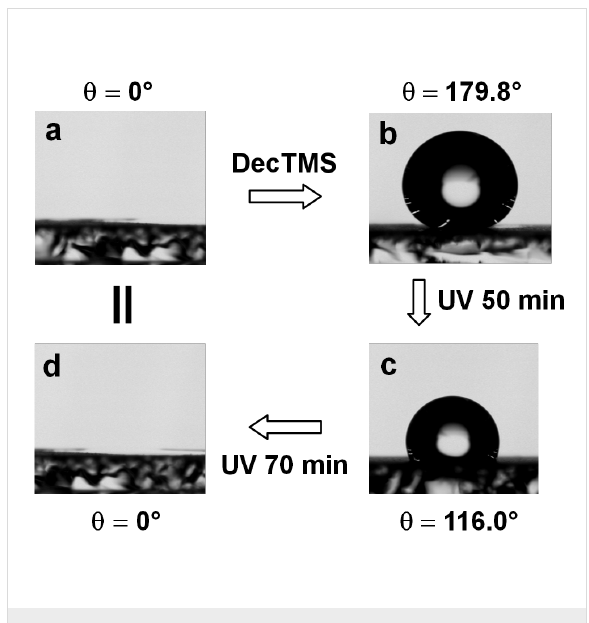
Figure 10: Water contact angles on the nanograss surface of (a) native superhydrophilic silica@titania, (b) superhydrophobic silica@titania after DecTMS modification, (c) hydrophobic silica@titania after 50 min UV irradiation and (d) superhydrophilic silica@titania after an additional 70 min irradiation (10 mW/cm − 2